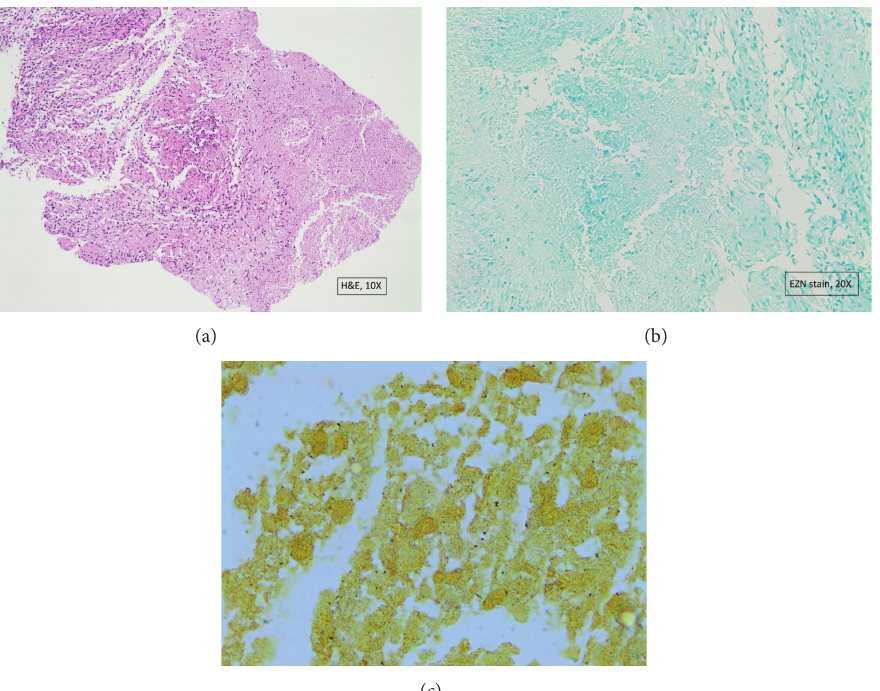
Figure 2: (a) The liver lesion is characterized by multiple granulomas hematoxylin and eosin × 10, (b) acid-fast Bacilli was not detected with EZN staining × 10, and (c) Bartonella henselae was demonstrated by Warthin-Starry silver stain × 10.